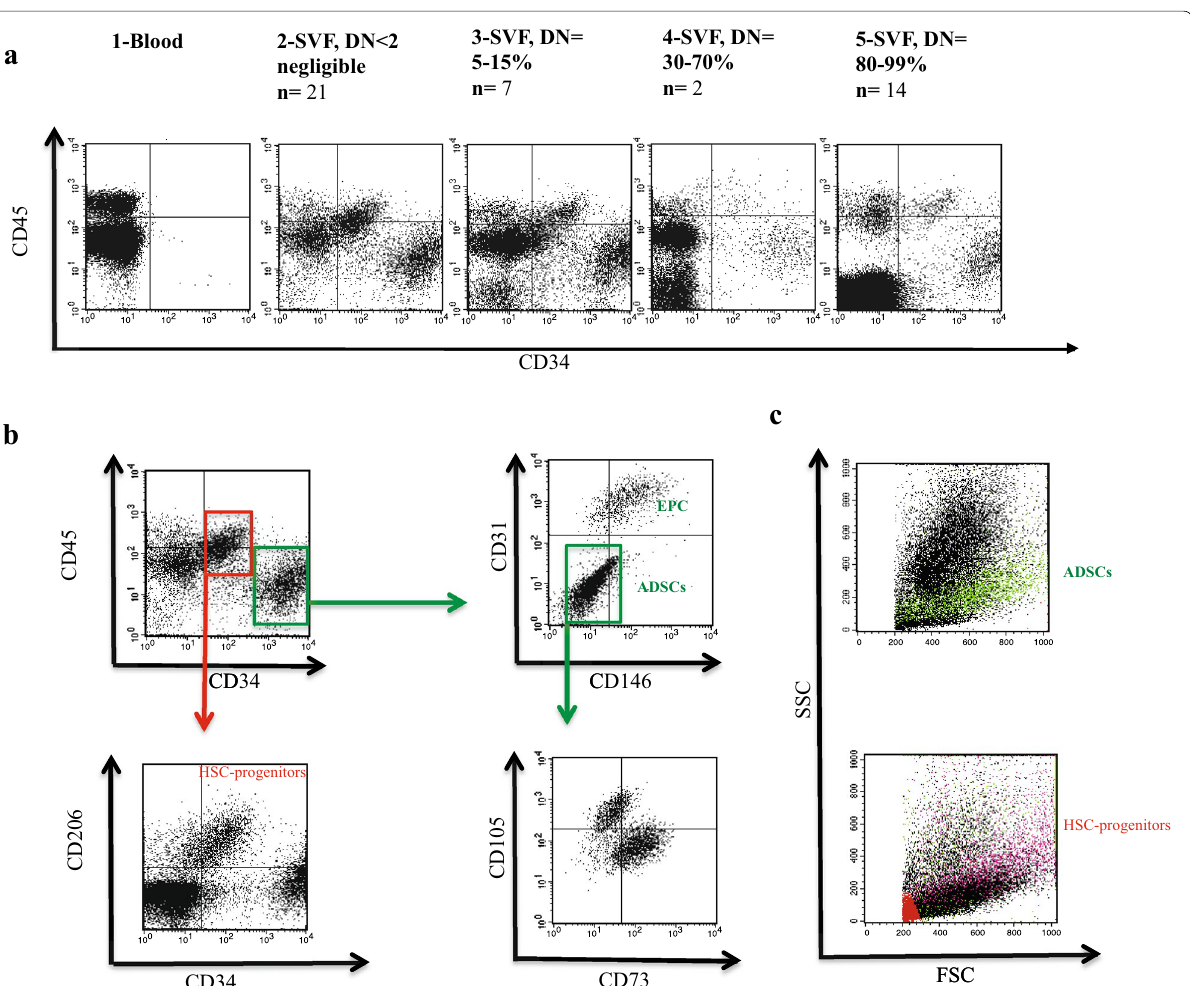
Fig. 2 Flow cytometry analysis of SVF. a shows a representative of CD45 and CD34 dot blot analysis for the different DN ratios. A1 is the blood analysis shown for the comparison and n represents the number of patient’s samples with the given percentage. b Detailed analysis of subpopula- tion phenotype. Arrows point the gating and each identified phenotype was marked with the corresponding nomenclature. c Back-gating analysis of ADSCs and HSC-Progenitors on forward and side scatter dot plot to show their cellular